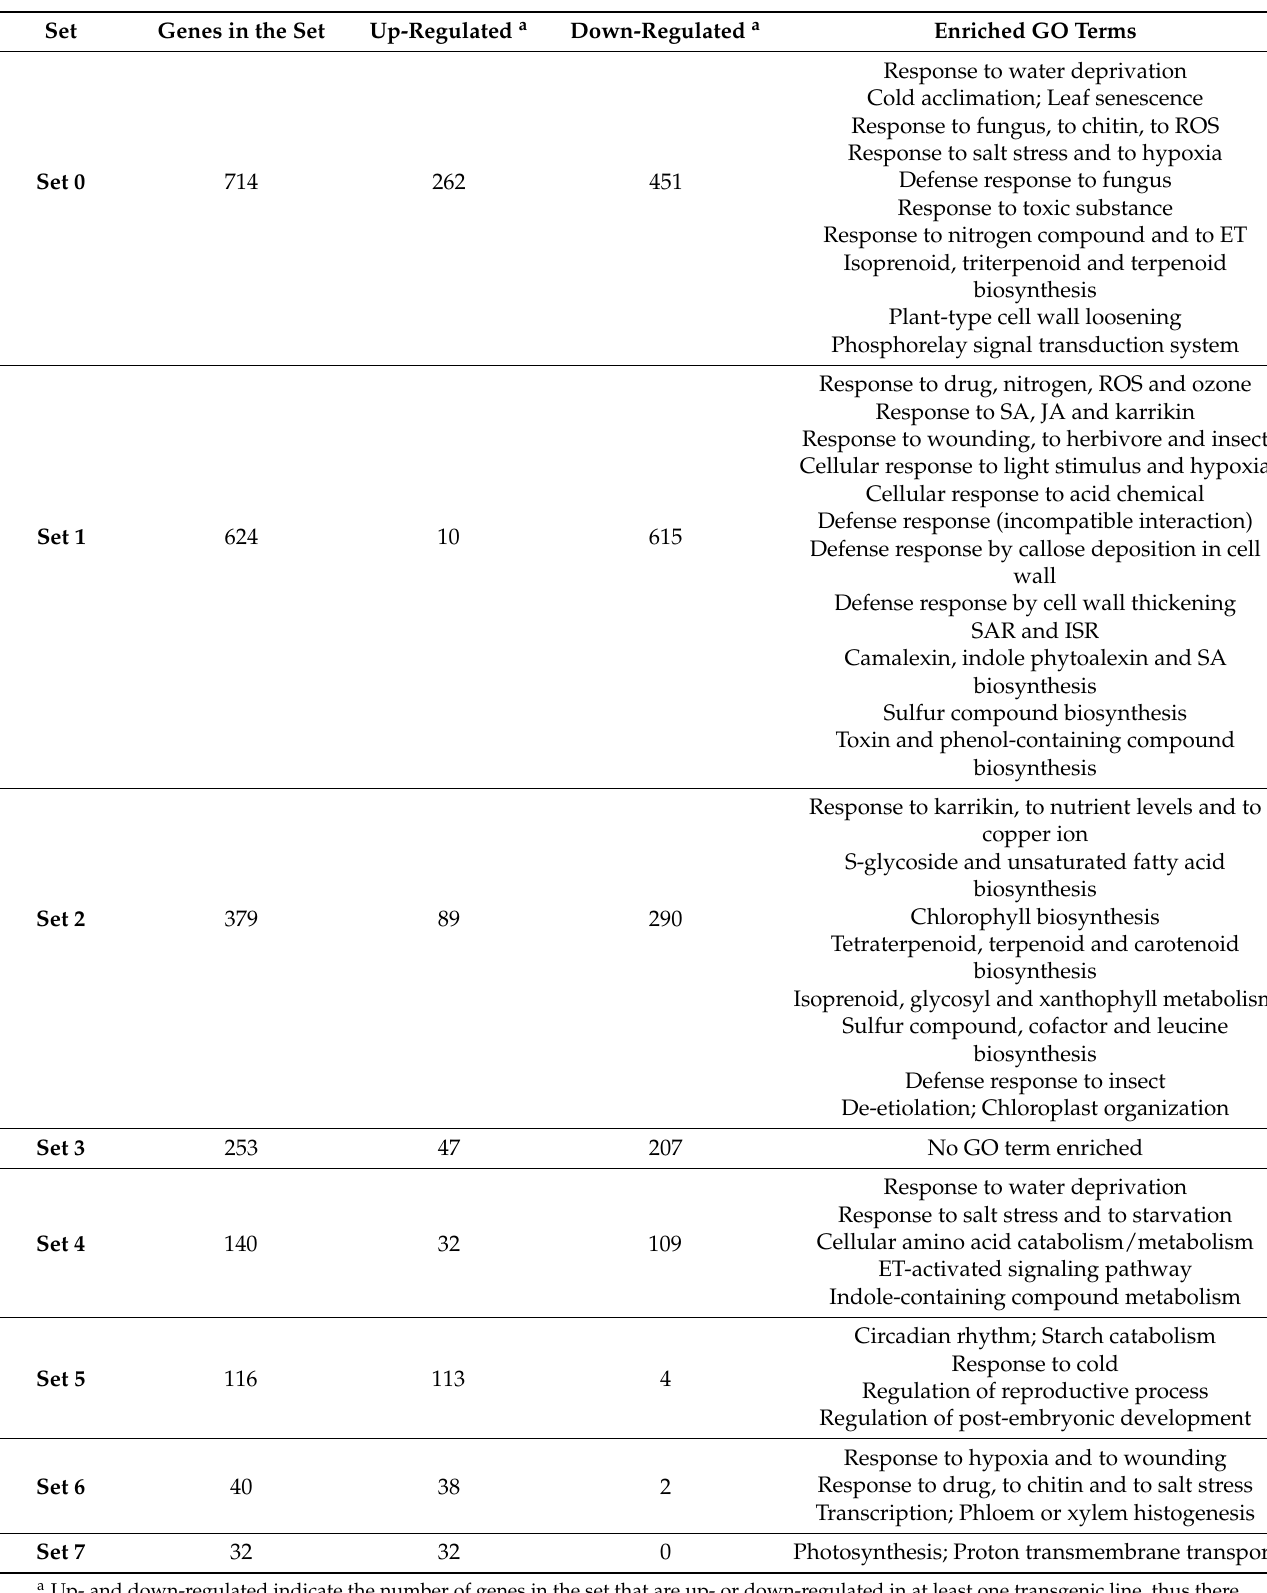
Table 2. Summary of “biological process” GO terms enriched in the WGCNA gene